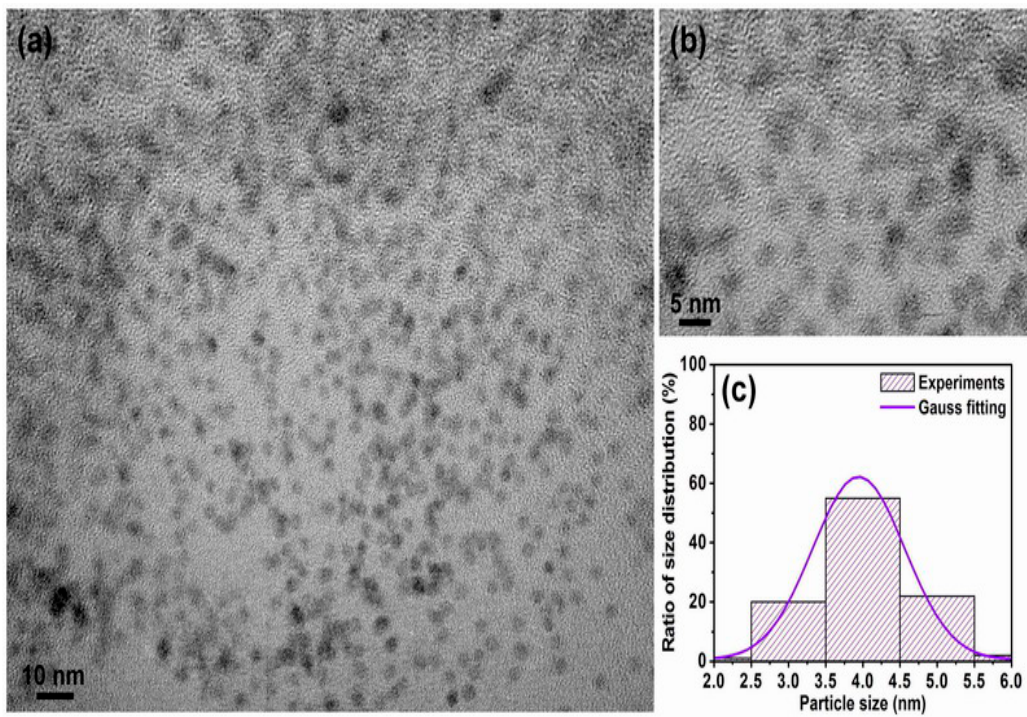
Figure 5. TEM bright field images for the FePt NPs synthesized in phenyl ether after ligand exchange with thiol. ( a ) Low-magnification image; ( b ) enlarged magnification of (a); ( c ) corresponding particle size distribution with Gauss fitting curve, respectively.